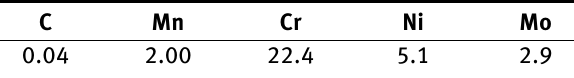
Table 3: Chemical composition of welding wire C Mn 0.01%